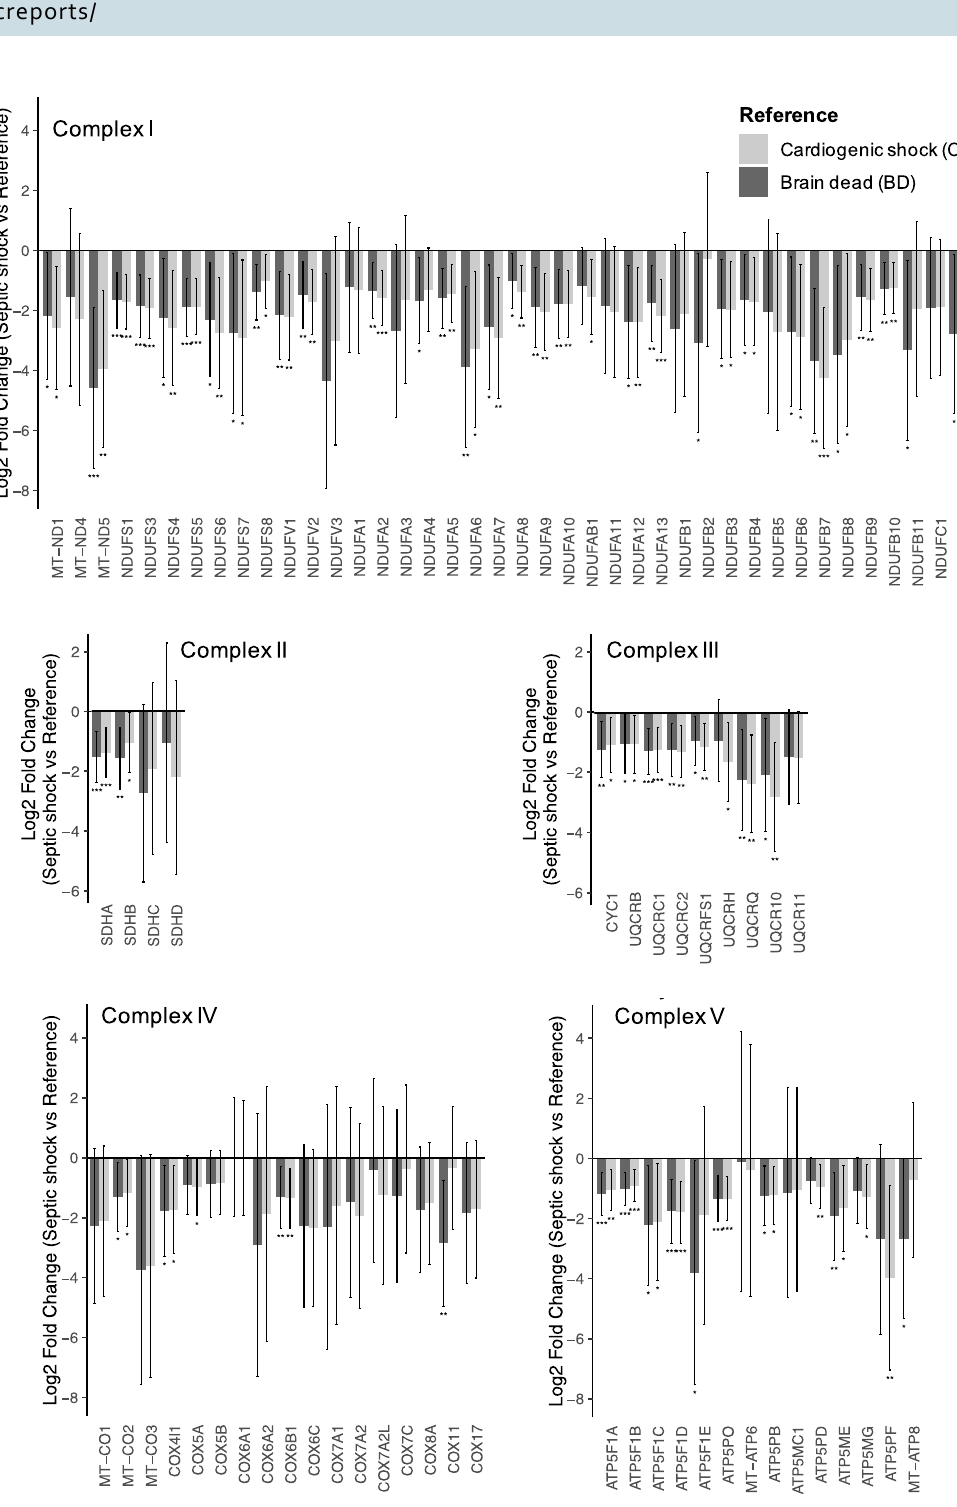
Figure 4. Mitochondrial complexes were decreased in the S group. The subunits of each mitochondrial complexes are represented. The subunits that were not identified in the proteomic dataset are not shown (Complex I : MT-ND2, MT-ND3, MT-ND6; Complex III : MY-CYB, UQCRHL; Complex IV : COX4l2, COX6B2, COX7B, COX7B2, COX8C, COX10, COX15; Complex V : ATP5MF). The bar represents the mean difference (Log 2 Fold Change) between the S group and the two control groups, the error bar represents the 95% confidence interval. N = 31 patients analyzed for the proteomics (Septic shock n = 12, cardiogenic shock n = 9, brain dead n = 10). * p < 0.05; ** p < 0.01; *** p < 0.001 (Tukey’s post-hoc test, Group S versus